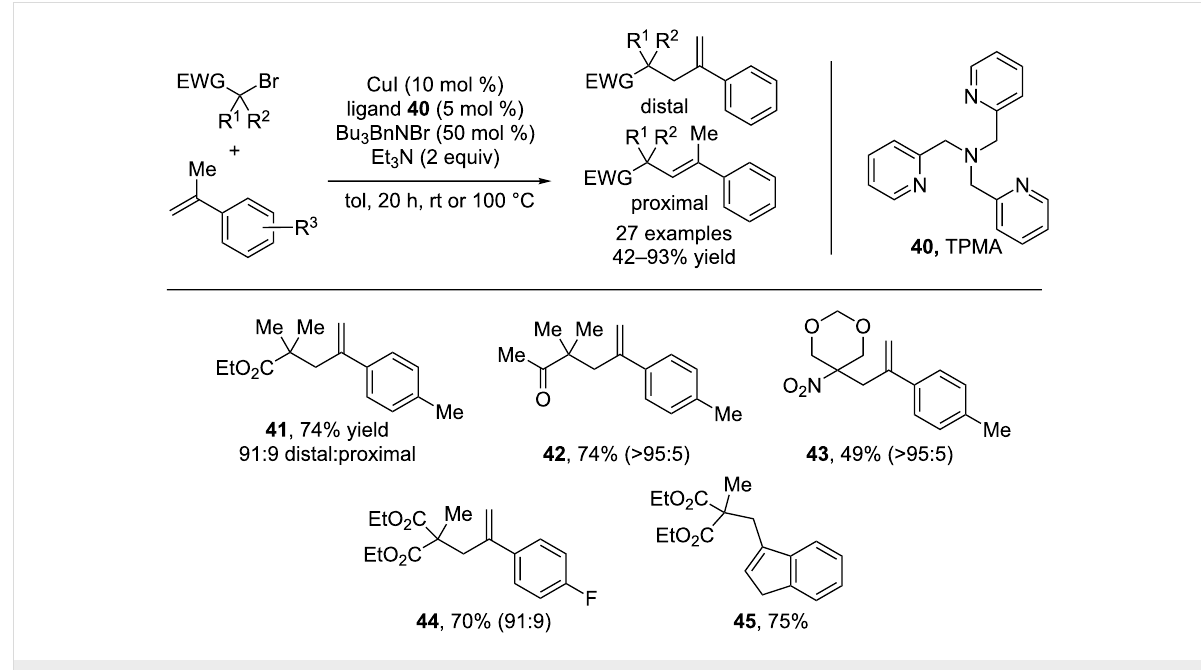
Scheme 11: Scope of the exo-methylene styrene